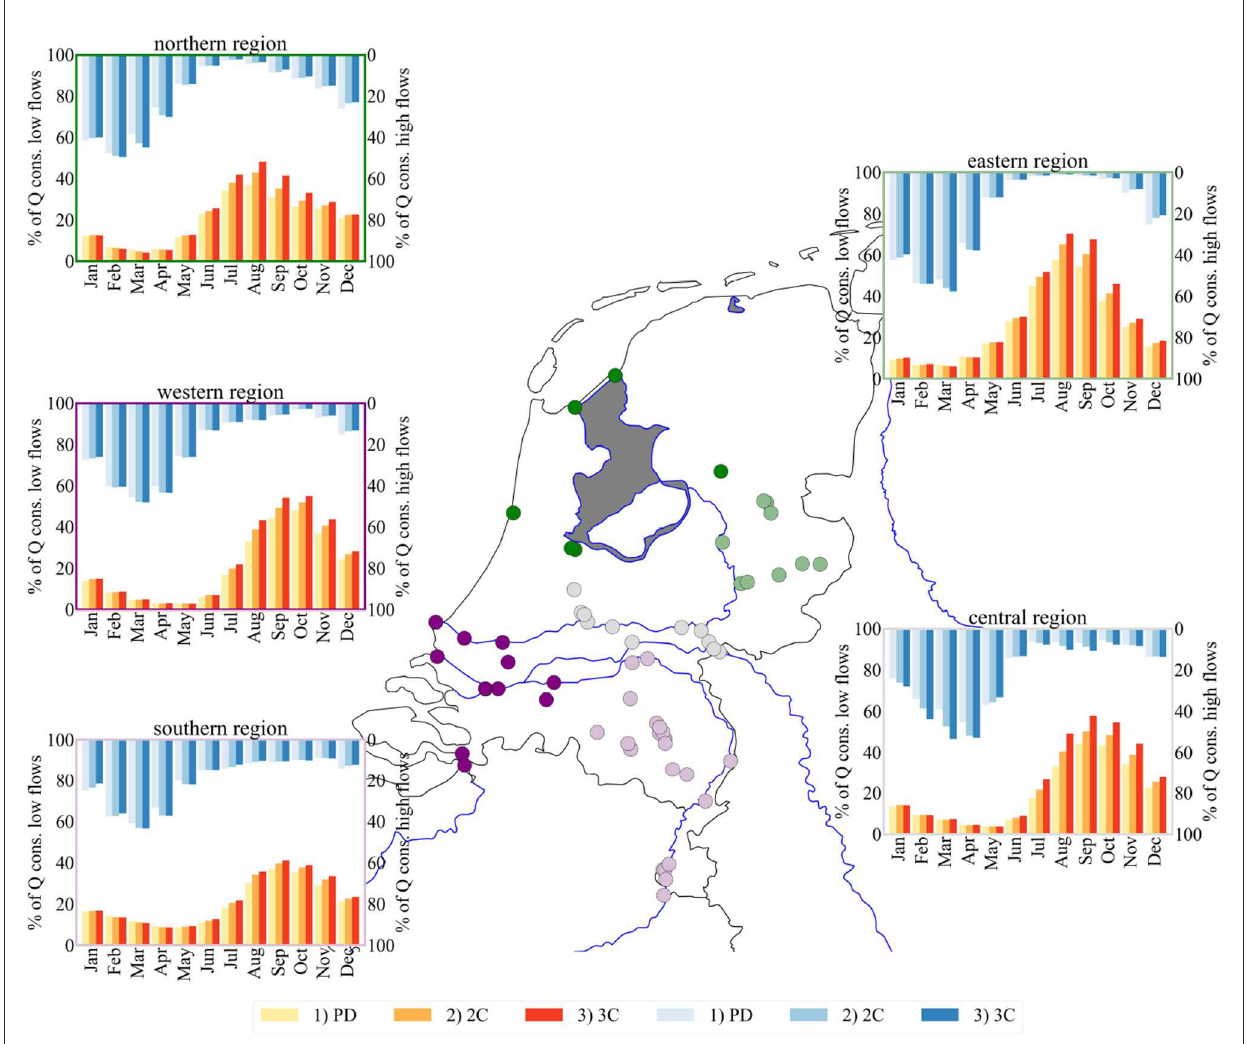
FIGURE5 Seasonal cycle of percentage of low and high flows under different scenarios PD, 2C and 3C, averaged over different regions (indicated by the group of dots with same color) based on the LSTM model results. Regions are defined into northern (dark green), eastern (light green), central (gray), southern (light pink) region and western (purple) region. Major rivers are presented by blue lines, while the dark gray area represents the IJsselmeer lake. Low flows are highlighted in yellow (PD), orange (2C), and red (3C), high flows in light blue (PD), blue (2C), and dark blue